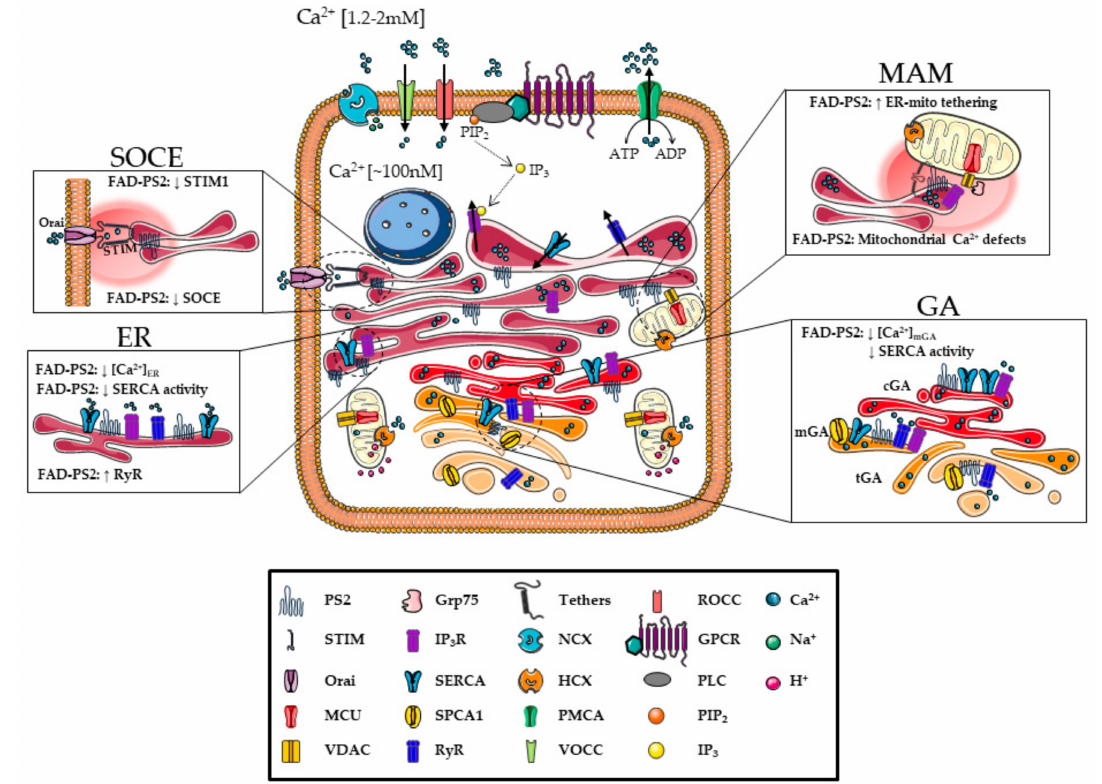
Figure 1. Ca 2 + signaling pathways and molecular toolkit and their dysregulation by FAD-PS2. Cytosolic [Ca 2 + ] ([Ca 2 + ] c ) can increase up to 1-3 µ M upon cell stimulation thanks to a highly complex molecular toolkit that cooperates to maintain cell Ca 2 + homeostasis. Ca 2 + can cross the PM through di ff erent types of Ca 2 + channels (ROCCs, SMOCCs, SOCCs, VOCCs) and / or it can be released from intracellular stores, primarily the endoplasmic reticulum (ER). Once the stores are depleted, a refilling process, called SOCE, occurs to restore their [Ca 2 + ]. Extrusion mechanisms, i.e., PMCA and NCX in the PM, and re-uptake processes, such as that mediated by SERCA pumps, restore the resting [Ca 2 + ] c . Finally,